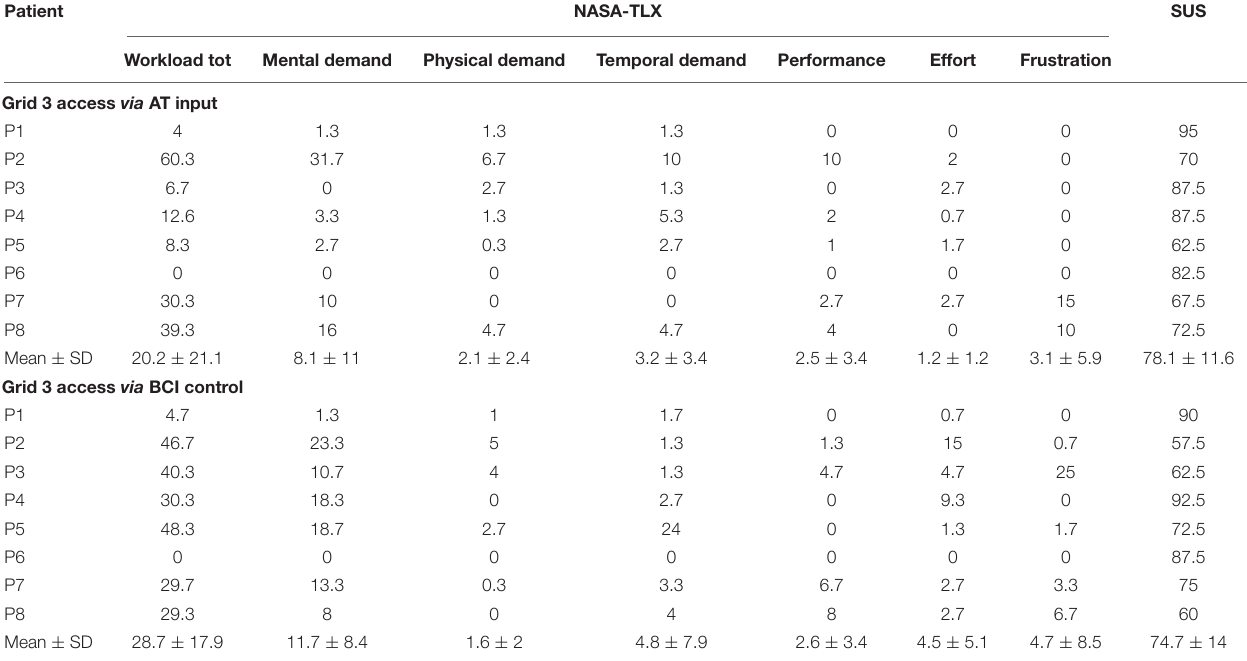
TABLE 4 | Scores for the NASA-tlx and SUS questionnaires in session II: Grid 3 access via AT input and Grid 3 access via BCI